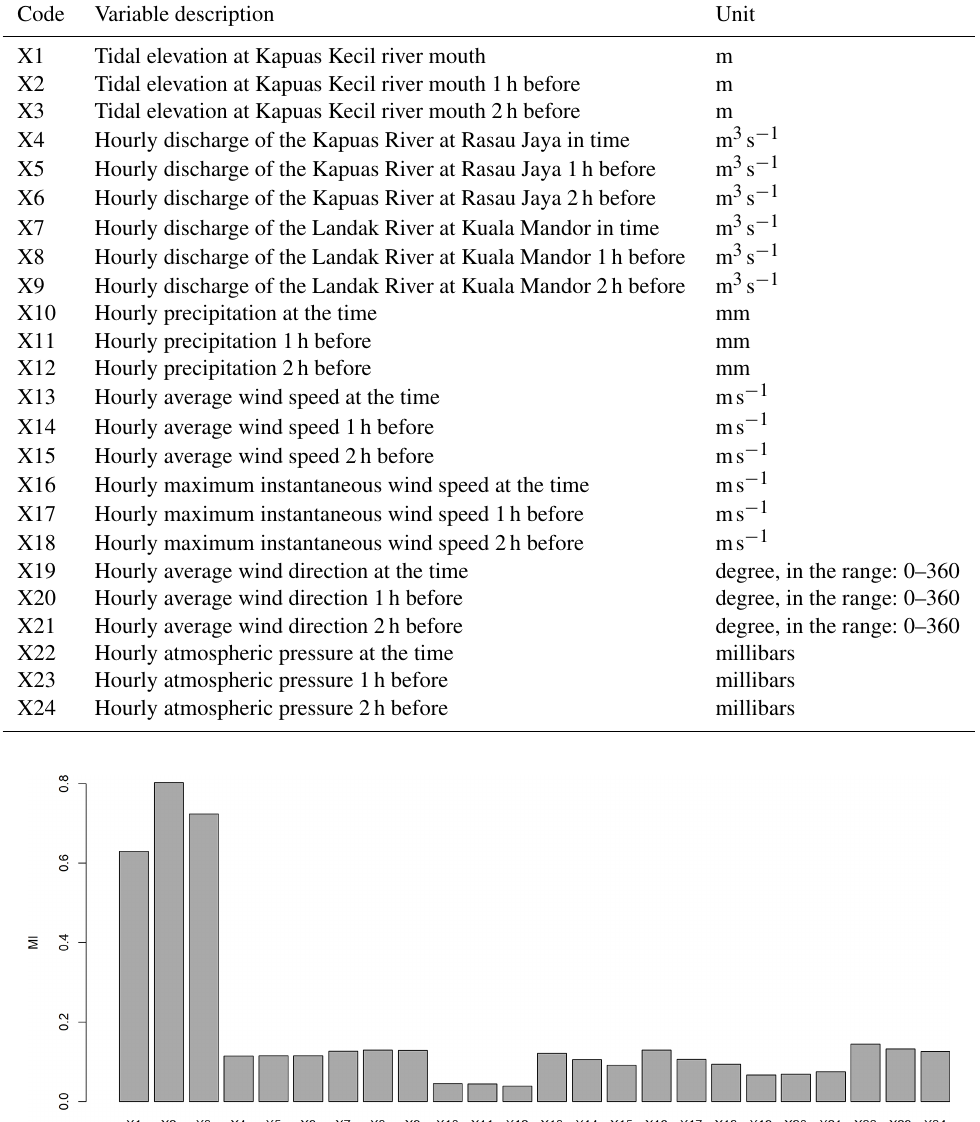
Table 2. The variables which are used as the predictors in this study.